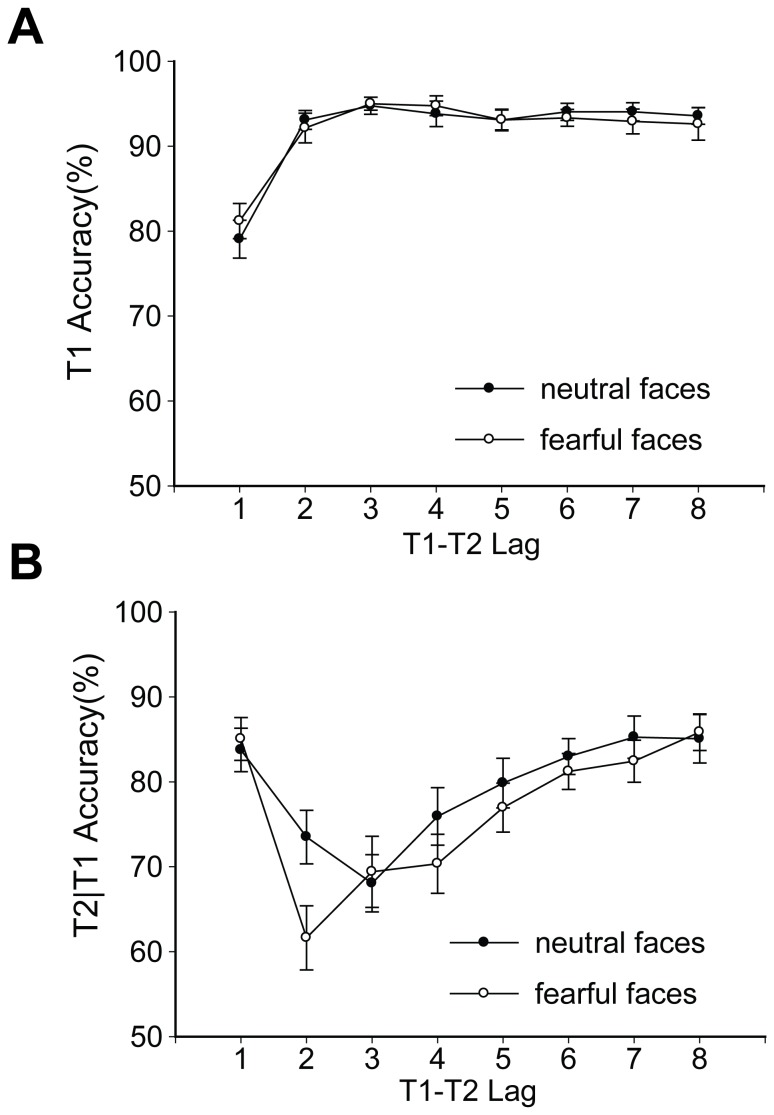
The average identification accuracy of targets in different emotional conditions of Experiment 2.(A) T1 performance; (B) T2 performance. The results are shown separately for the neutral and fearful conditions. Error bars represent one standard error of the mean.